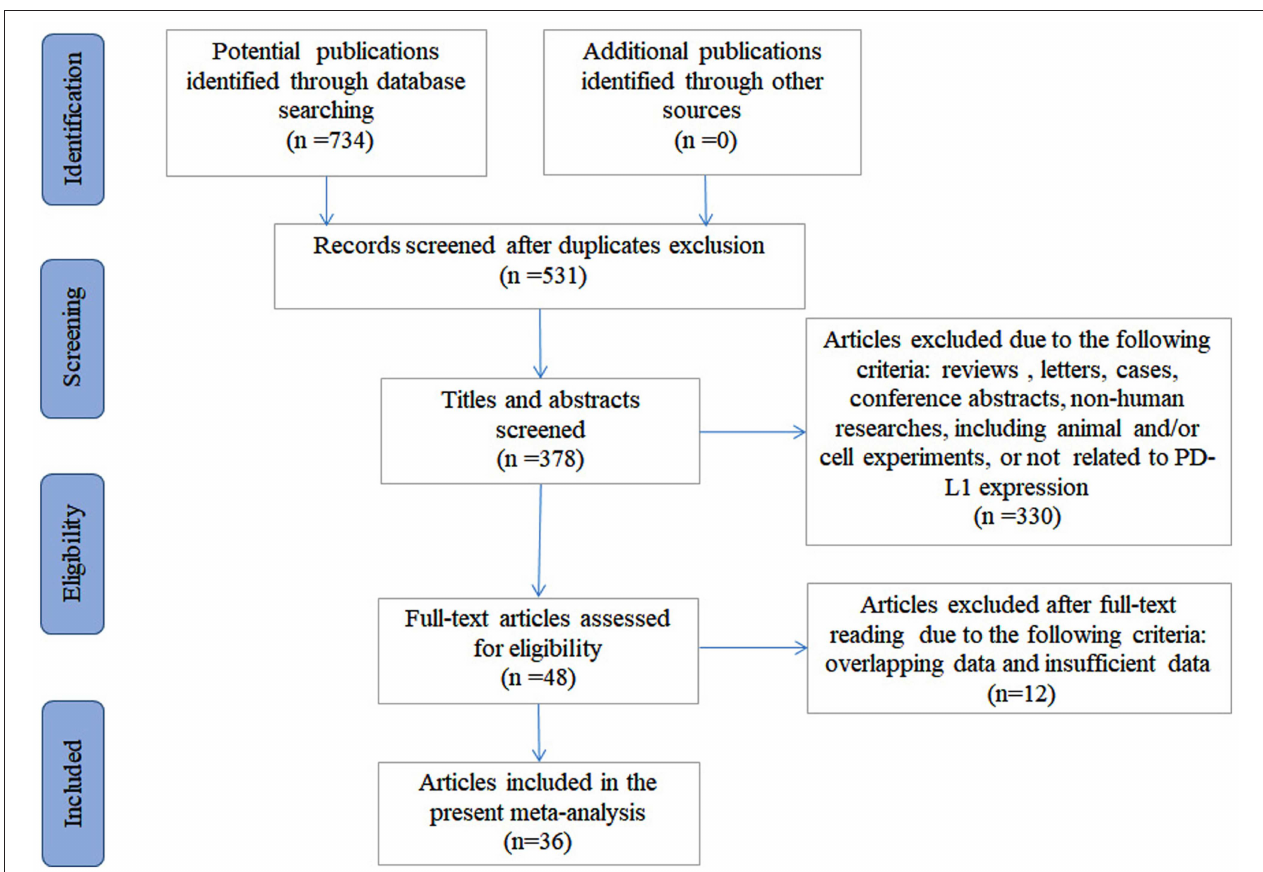
FIGURE 1 | Flow diagram of the study selection